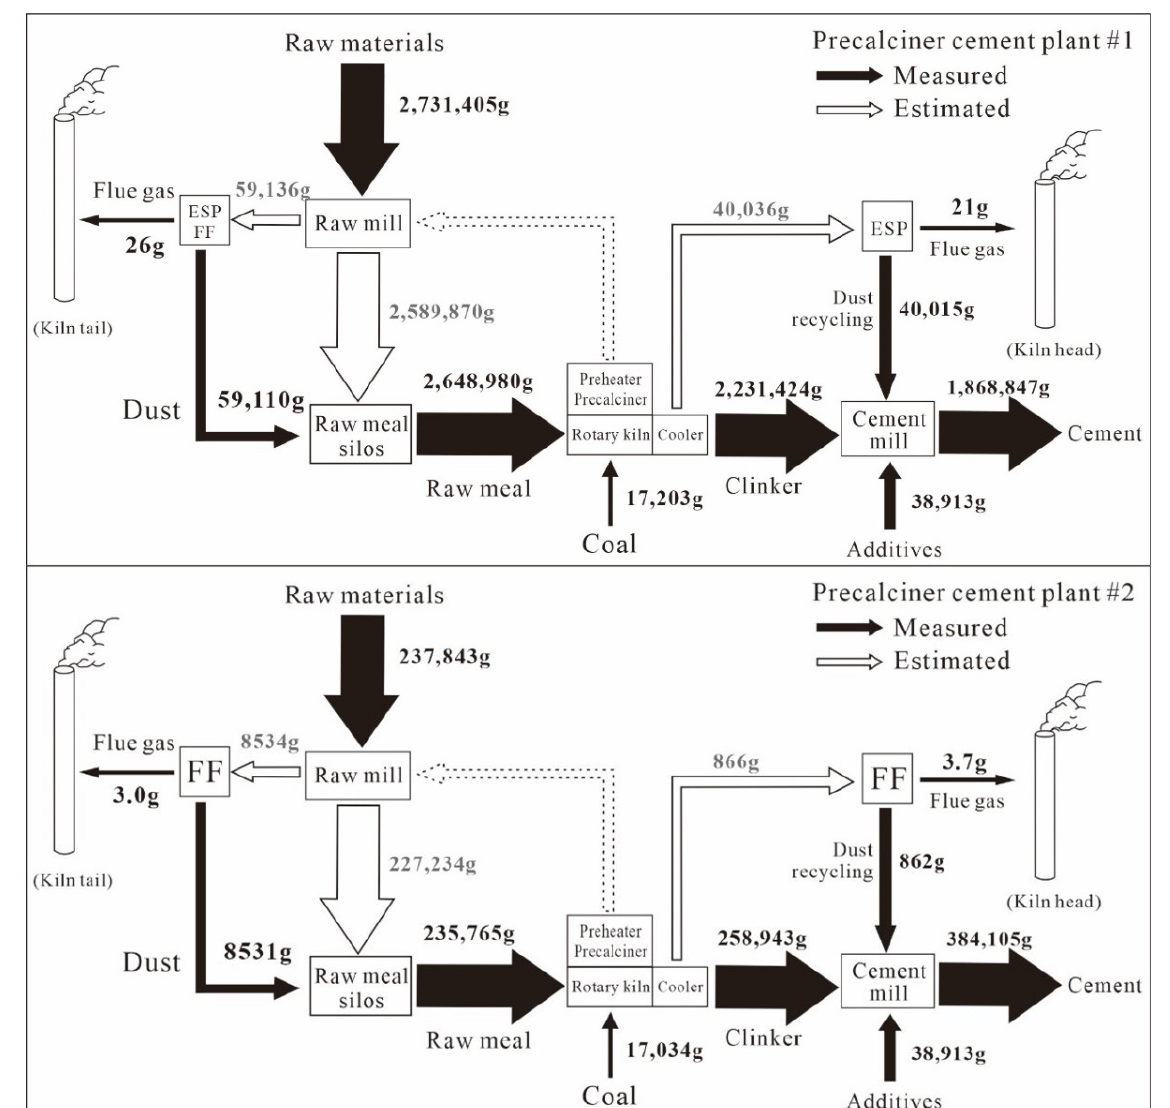
Figure 4. Zn mass flows throughout the production process in two CPs. (Values are based on one day).